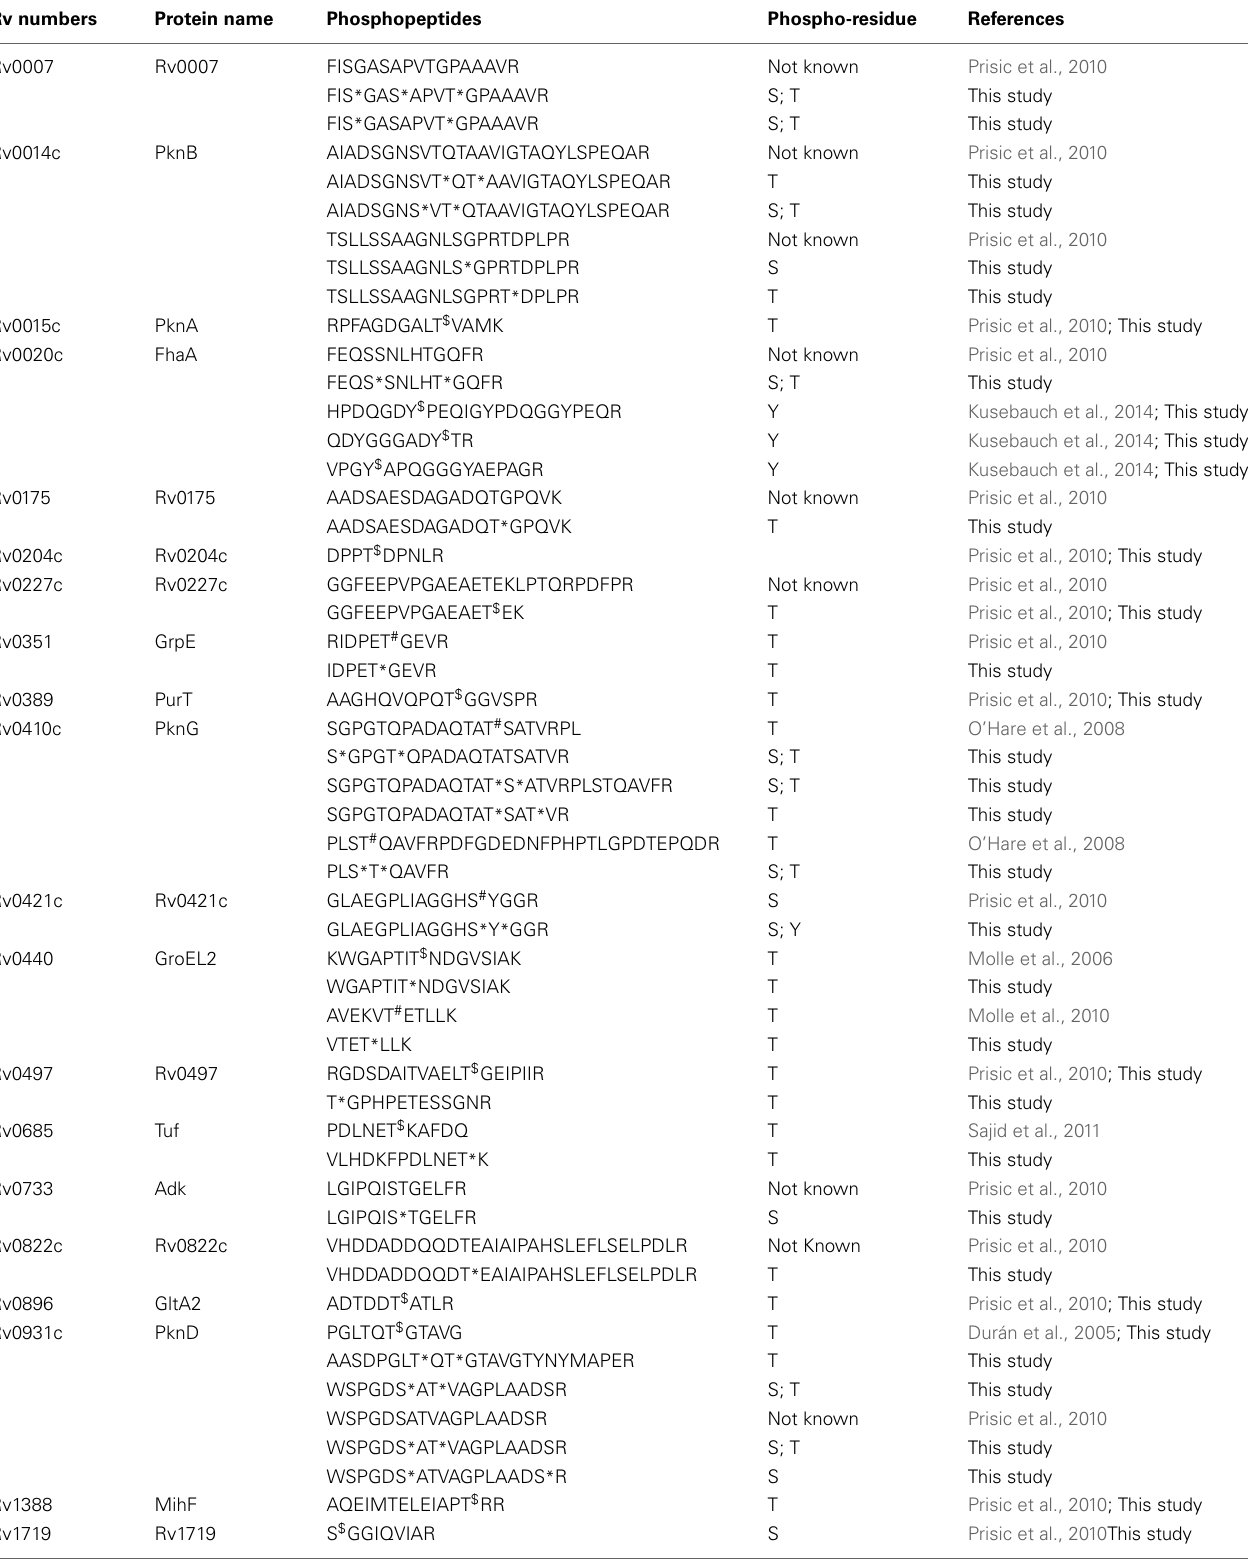
Table 1 | List of phosphopeptides identified in this and previous studies of M. tuberculosis